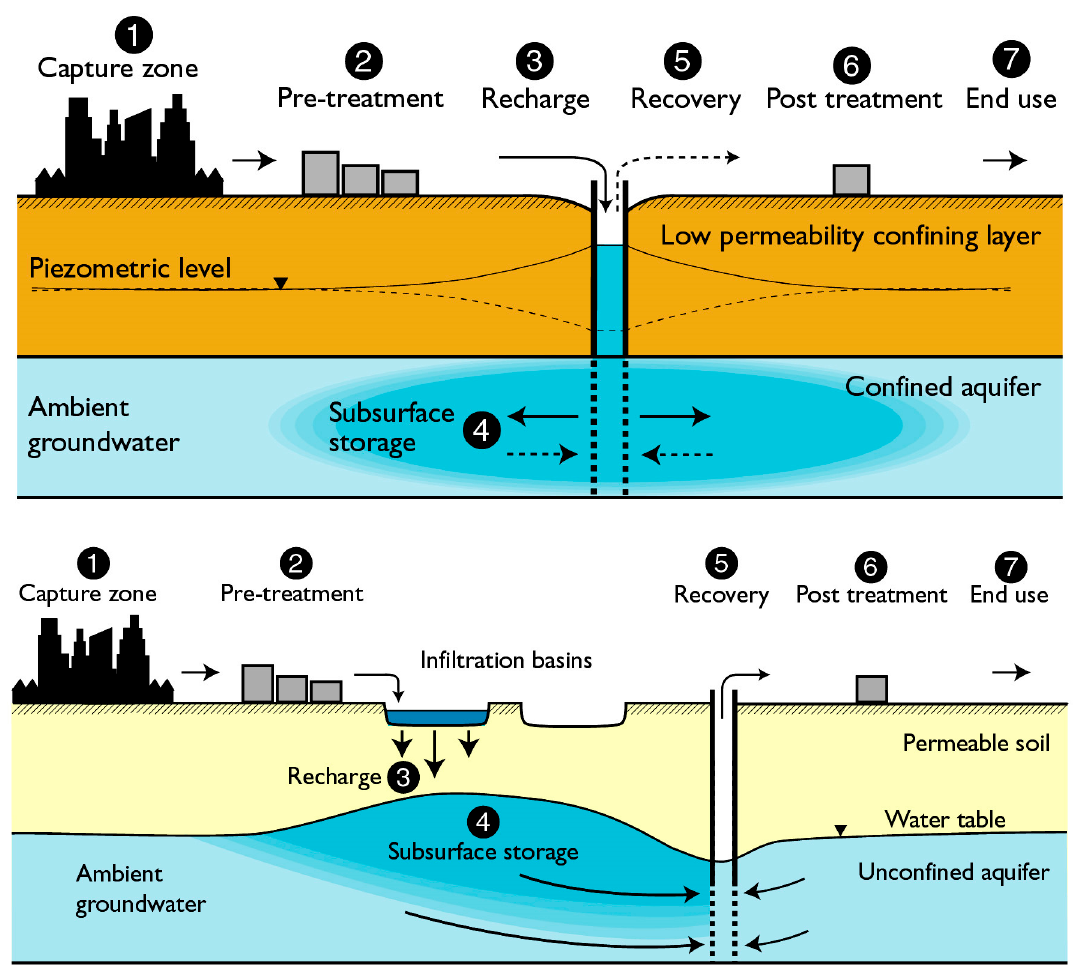
Figure 1. MAR injection and infiltration schemes. Top: Aquifer Storage and Recovery. Bottom: Soil Aquifer Treatment (after [28]).